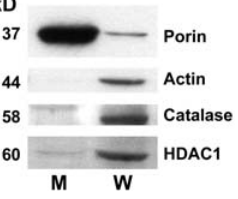
Figure 1. Mitochondria were highly purified as demonstrated by the relative expression of the mitochondrial specific protein, porin; the cytoplasmic protein, catalase; the nuclear protein, HDAC1; and actin in mitochondrial (M) and whole cell (W) fractions. Extracts were subject to immunoblot analysis using the antibody to the indicated protein. Findings are representative of four different mitochondrial preparations.